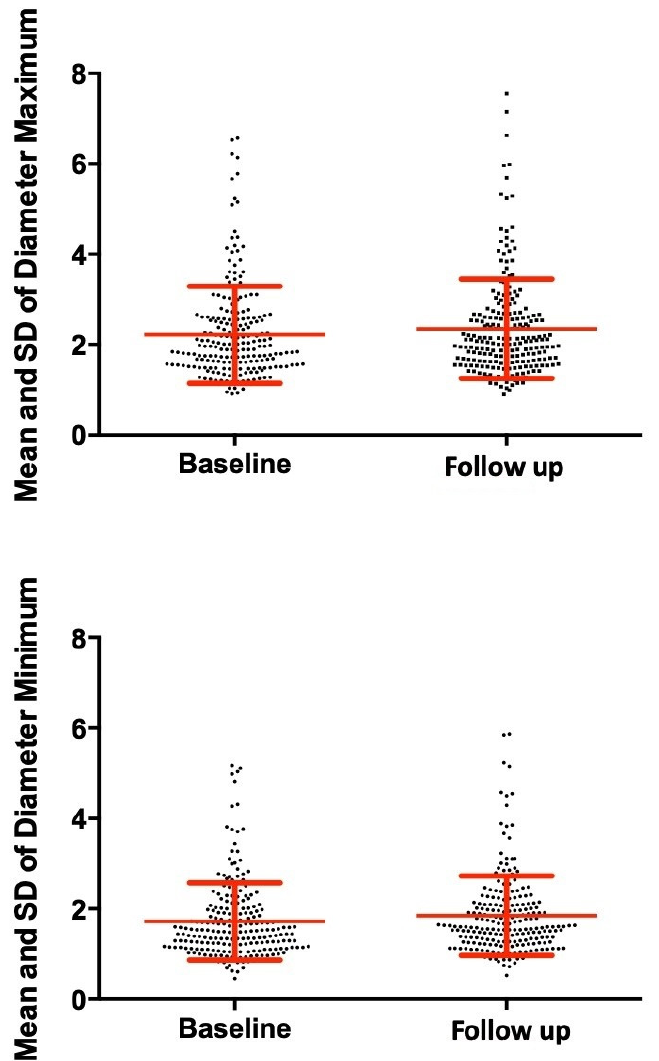
Figure 1. Mean and standard deviation (SD) of diameters (mm) at baseline and follow ‐ up.